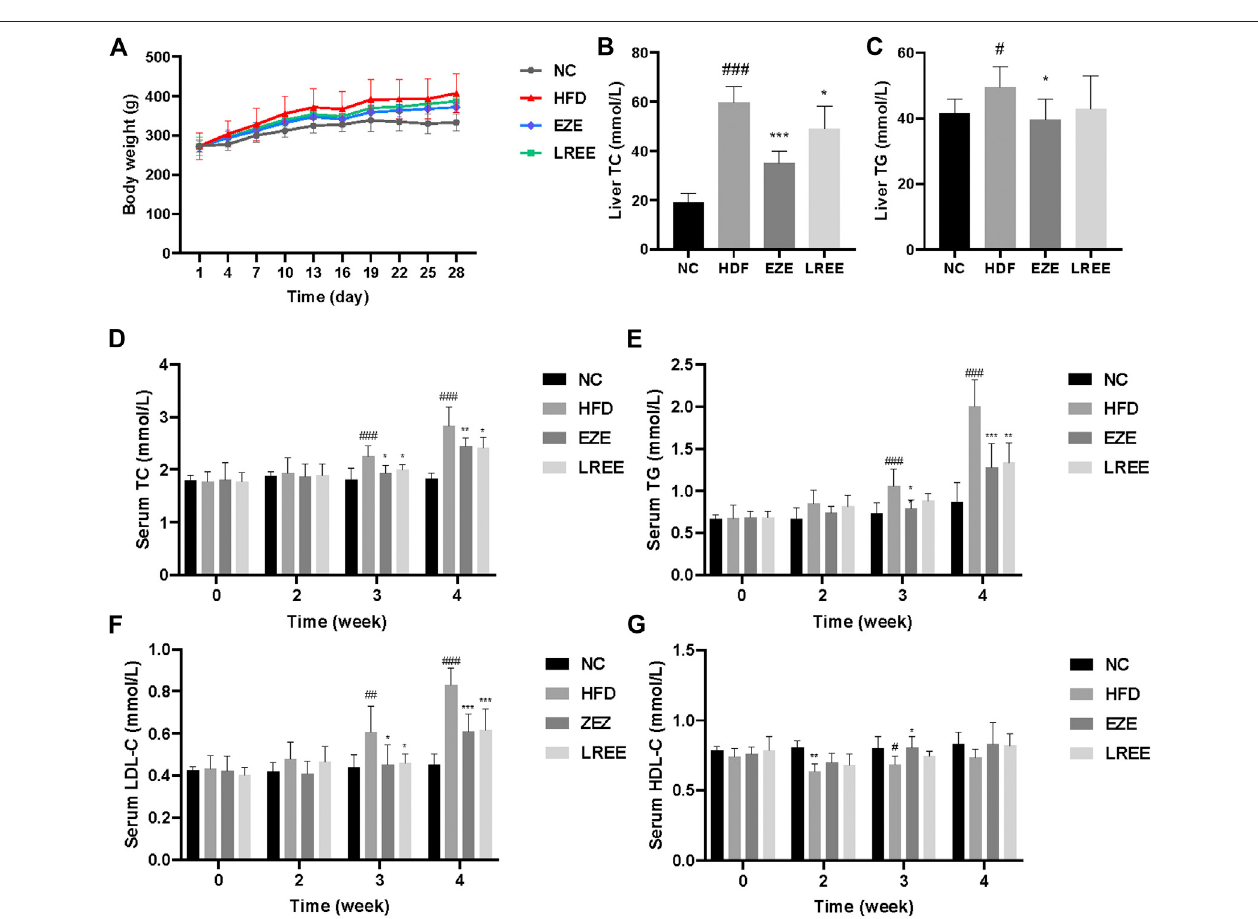
FIGURE2| EffectsofLREEonHFD-inducedhyperlipidemiainrats. (A) Bodyweight duringmodelingtime. (B) TClevelsintheliver. (C) TGlevelsintheliver. (D) TC levels in the serum. (E) TG levels in the serum. (F) LDL-C levels in the serum. (G) HDL-C levels in the serum. # p < 0.05, ## p < 0.01, ### p < 0.001 via the NC group; * p <